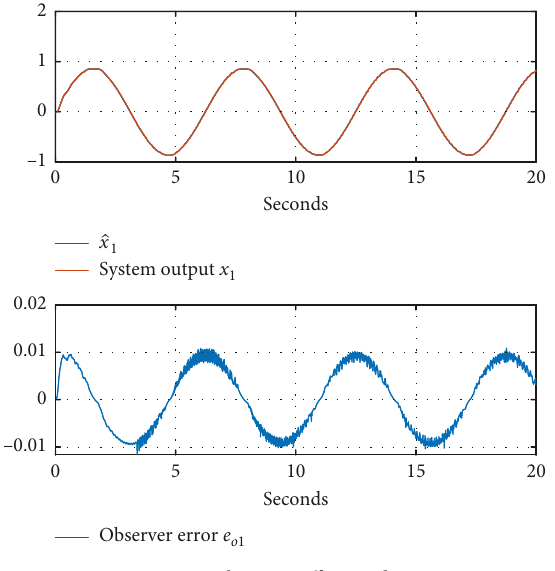
Figure 12: Observer effect and